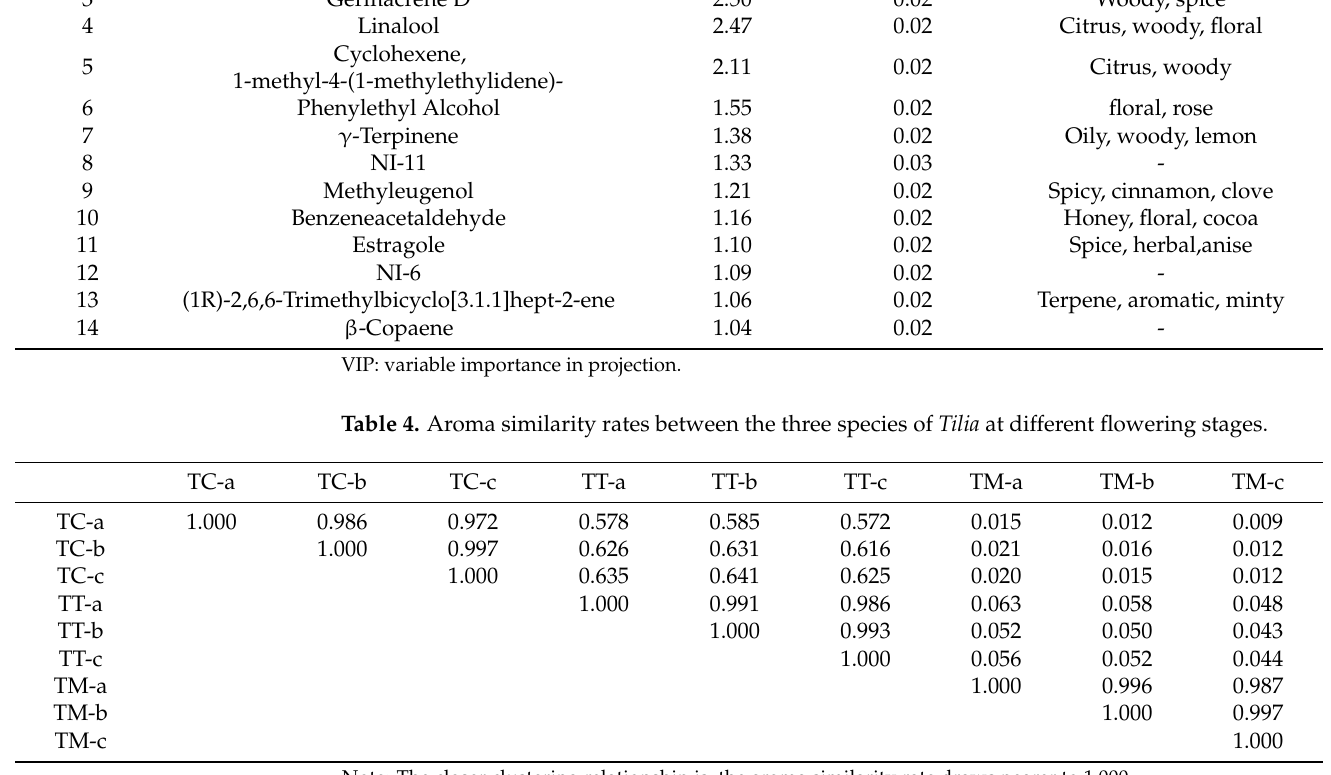
Table 3. Characteristics of the 14 crucial components in the PLS-DA model.